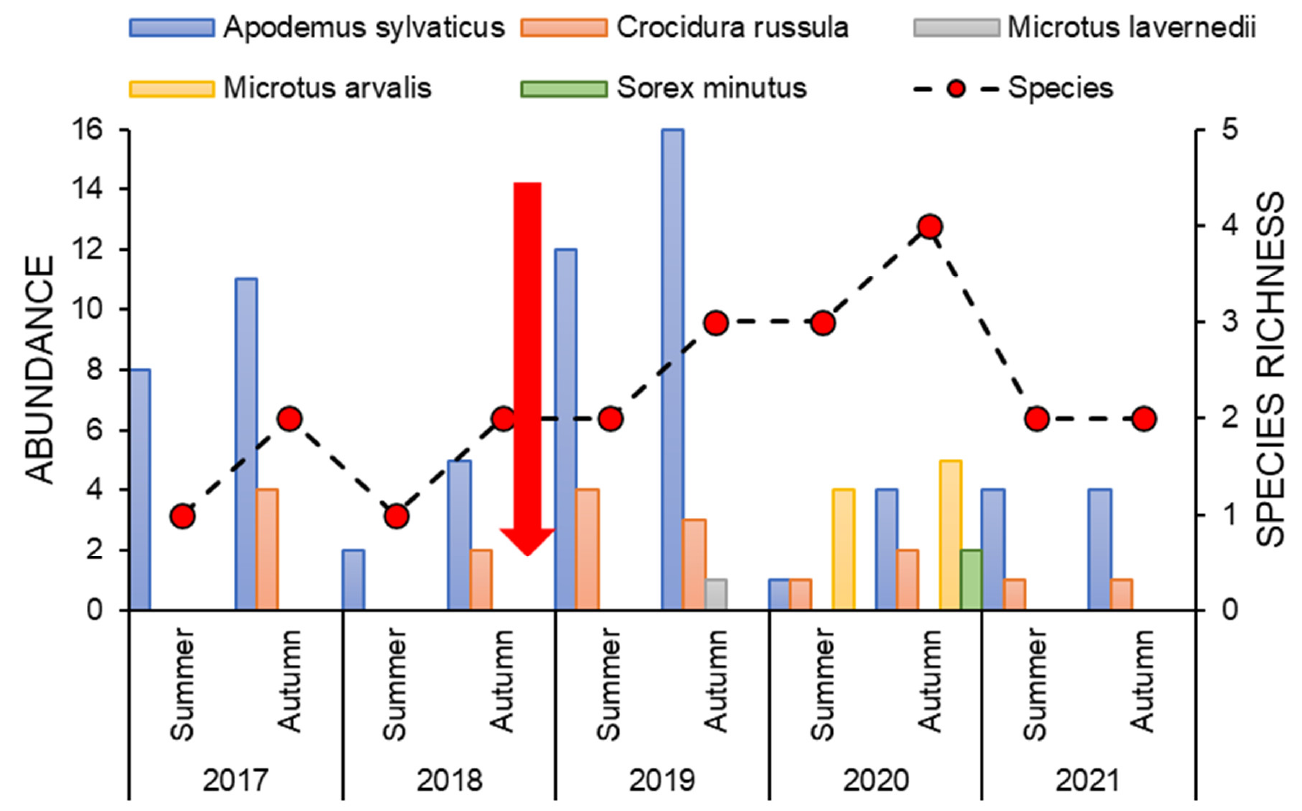
Figure 2. Number of small mammal individuals captured (left axis) and species density (right axis) along the study period (summer 2017–autumn 2021). The red arrow indicates the intervention to control for shrub encroachment.